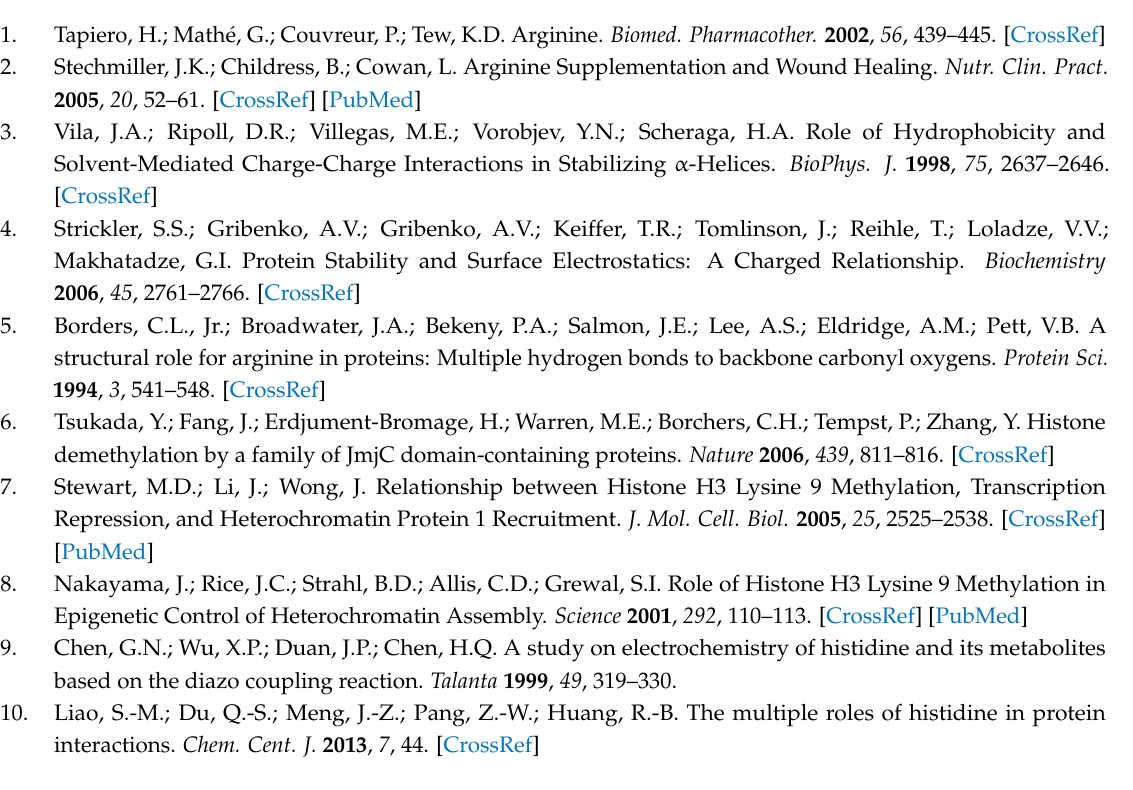
Table S1: Experimental details for